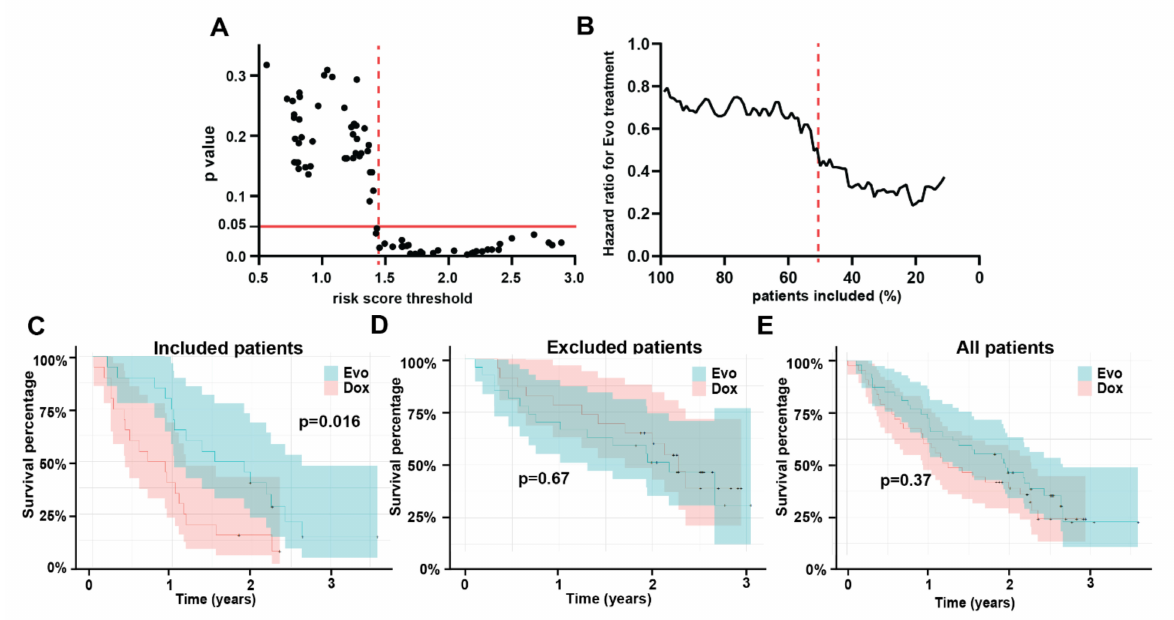
Figure 3. Results in the test cohort confirm the validity of the model. Risk scores predictions in the test cohort based on a multivariable Cox model trained on Dox treated training cohort patients can be used to identify patients who would benefit from Dox + Evo treatment. Graph in ( A ) shows that increasing the minimum risk score of patients included in the analysis leads to a stronger difference in survival between the treatment groups, as described by the p value of the comparison. For the risk score threshold of 1.45, a highly significant difference is observed (red point and dotted line), which corresponds to a decreased hazard ratio of the combination vs. standard therapy ( B ). These differences are apparent from the Kaplan-Meier curve in the included patients ( C ) showing significantly longer survival in the Dox + Evo group, while the excluded patients ( D ), or all test set patients ( E ) show no difference in survival between treatment